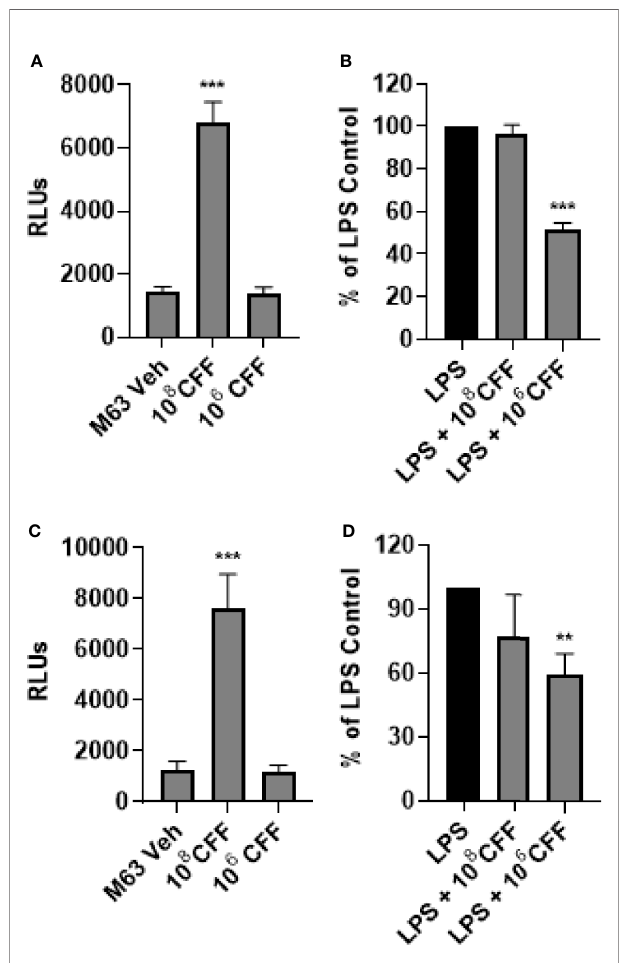
FIGURE 6 | L. acidophilus cell free fi ltrate (CFF) affects NF- k B activity. Using a luciferase NF- k B reporter THP-1 cell line, monocytes and monocyte derived macrophages were incubated with L. acidophilus CFF alone or added 1 h after LPS stimulation, for 20 h. Luciferase luminescence was measured to quantify NF- k B activation. (A) In monocytes, 10 8 CFF alone upregulated NF- k B activation but 10 6 CFF had no effect. (B) In LPS stimulated monocytes, only 10 6 CFF reduced NF- k B activity. (C) L. acidophilus 10 8 CFF increased NF- k B activity in monocyte derived macrophages. (D) Similar to monocytes, only L. acidophilus 10 6 CFF signi fi cantly reduced NF- k B activity in monocyte derived macrophages. Data are relative light units (RLUs) or mean ± s.e.m. percent change from LPS control adjusted to 100%. **p < 0.01, ***p < 0.001 compared to appropriate control; monocytes n = 7 independent experiments; macrophages n = 8 independent